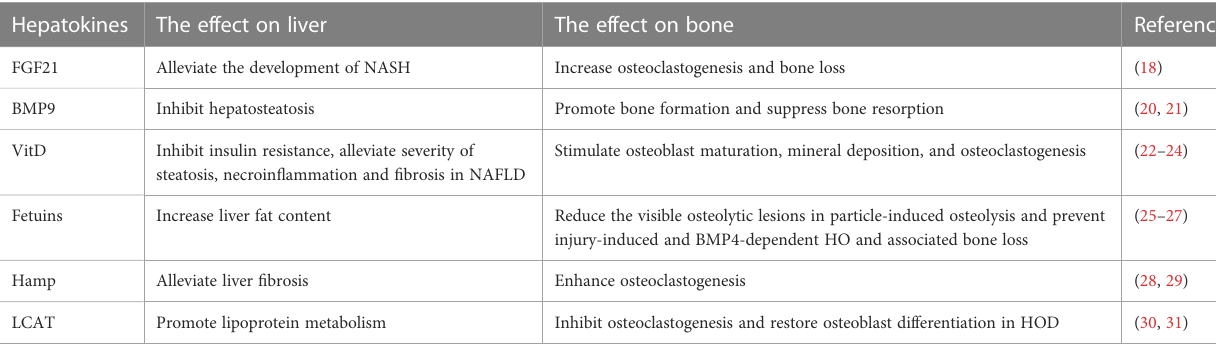
TABLE 1 Hepatokines involved in bone